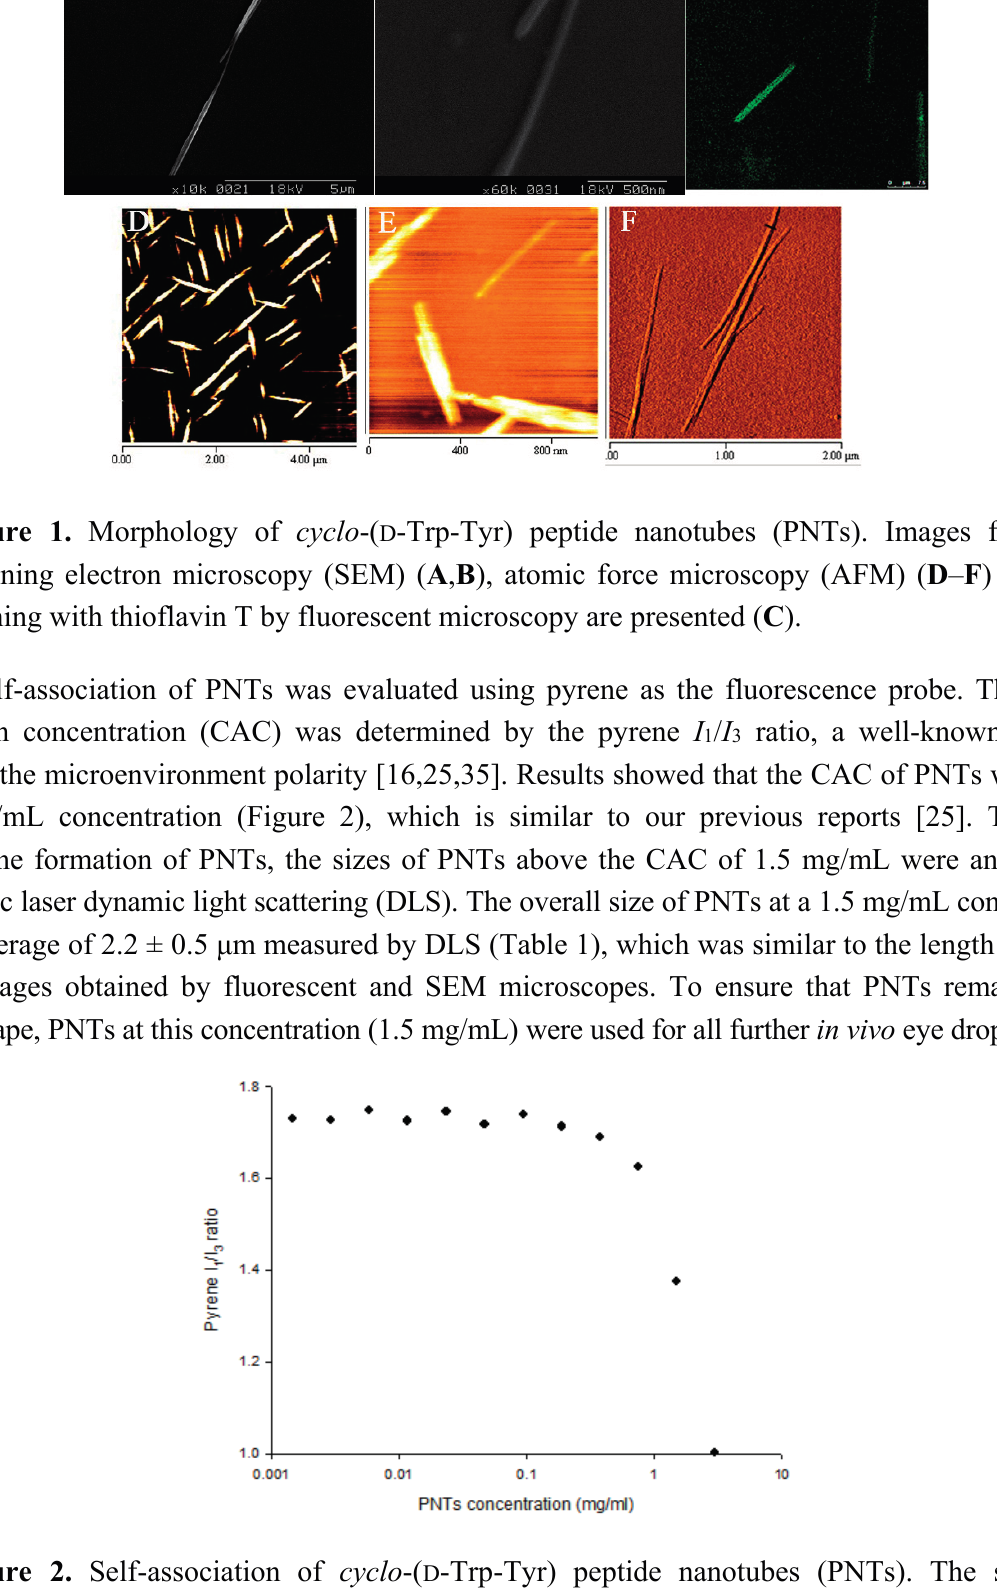
Figure 2. Self-association of cyclo -( D -Trp-Tyr) peptide nanotubes (PNTs). The self- association property was estimated by a pyrene fluorescence probe. For the pyrene solution, 6.7 × 10 − 7 M was used, and the critical association concentration (CAC) was determined by the turning point of I 1 / I 3 ratio represented as a solid circular